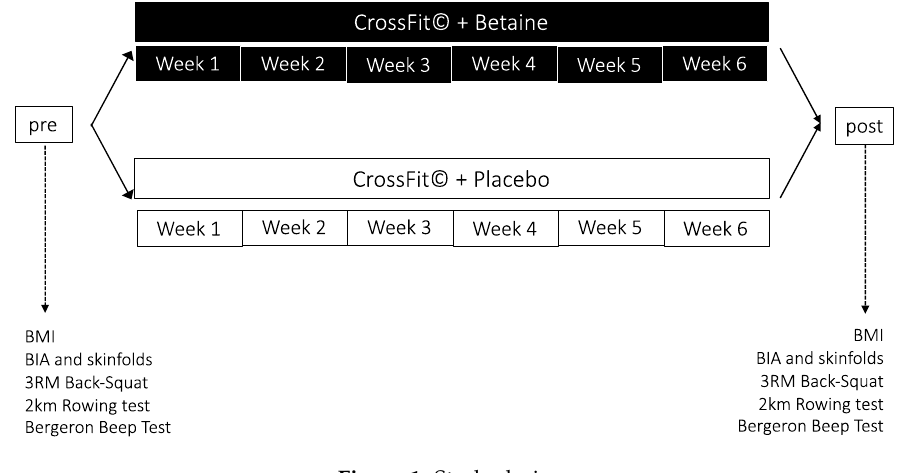
Table 1. Baseline characteristics of Betaine (BET) and placebo (PLA) groups.